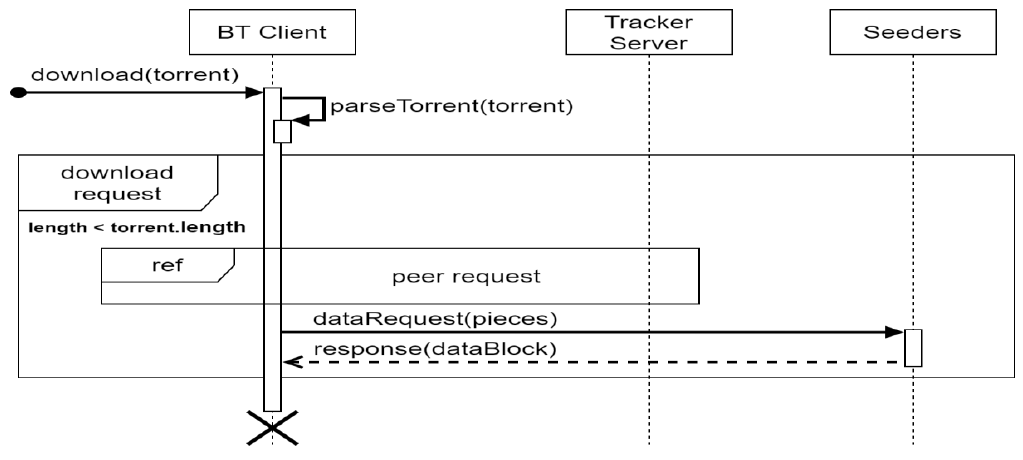
Figure 2 . The download process of BT . Figure 2. The download process of